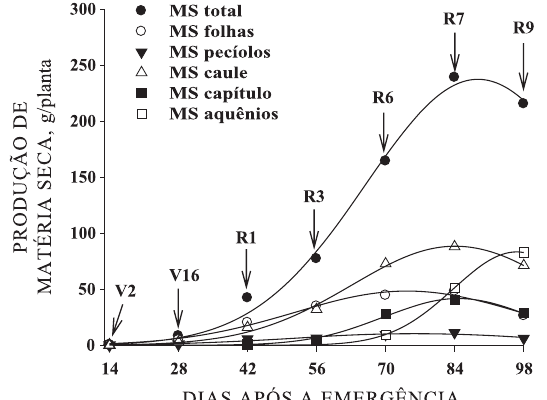
Figura 1. Acúmulo de matéria seca total das respectivas partes da planta amostradas, em função do